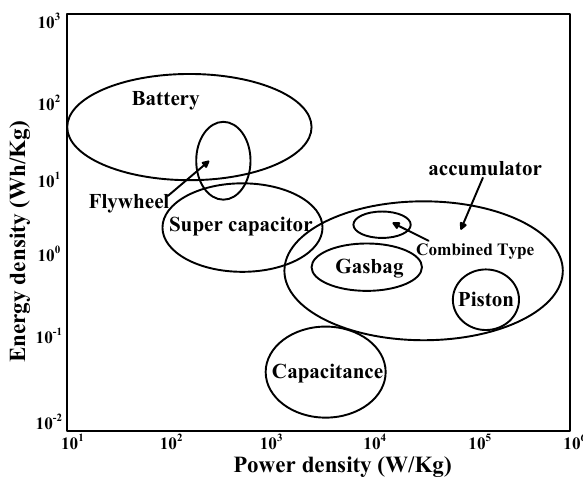
Figure 2. Power density and energy density of different energy ‐ recovery systems.